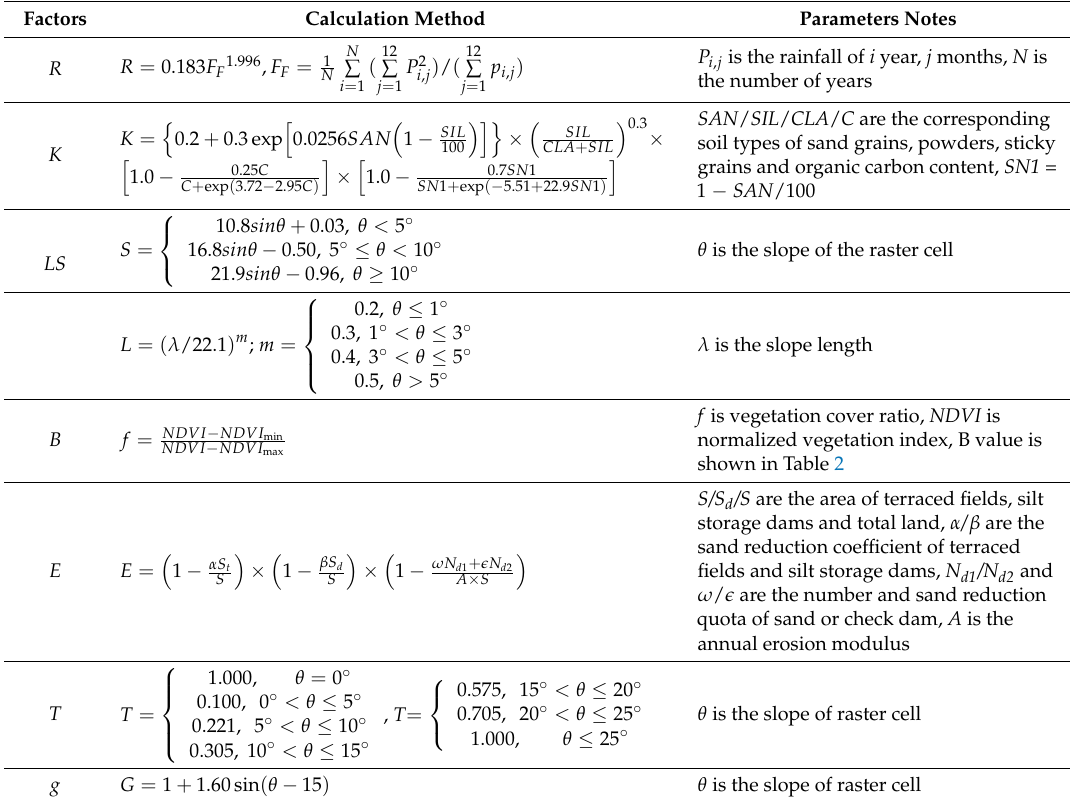
Table 1. Soil erosion model factors calculation method.